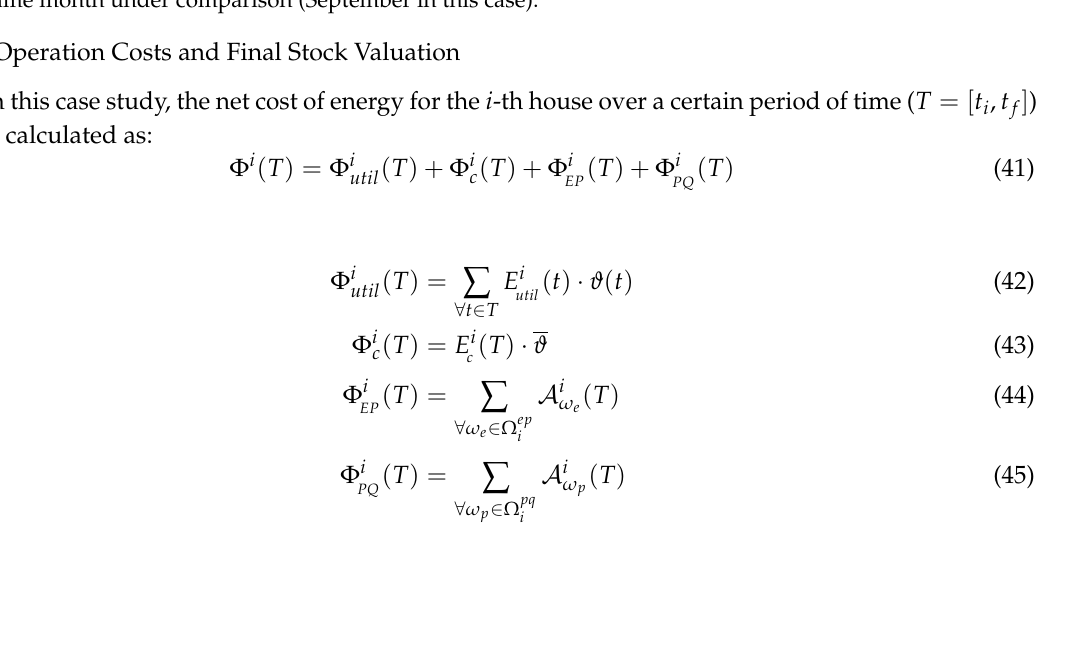
Figure 3. Scenarios for the MS-SMPC are the prices and liquidity profiles for 30 simulated days of the same month under comparison (September in this